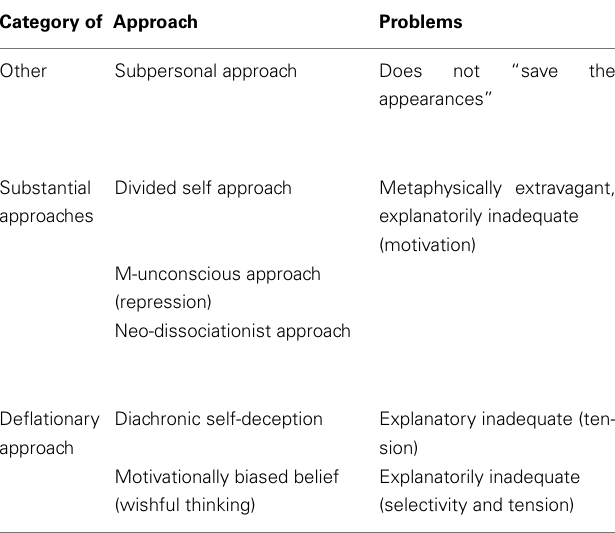
Table 1 |The various approaches to apparent